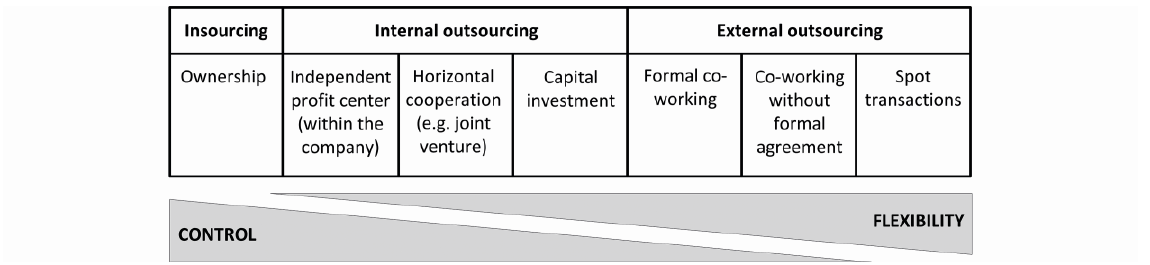
Figure 2. Structural alternatives in outsourcing design which give varying possibilities with respect to control and flexibility. Based on Arnold